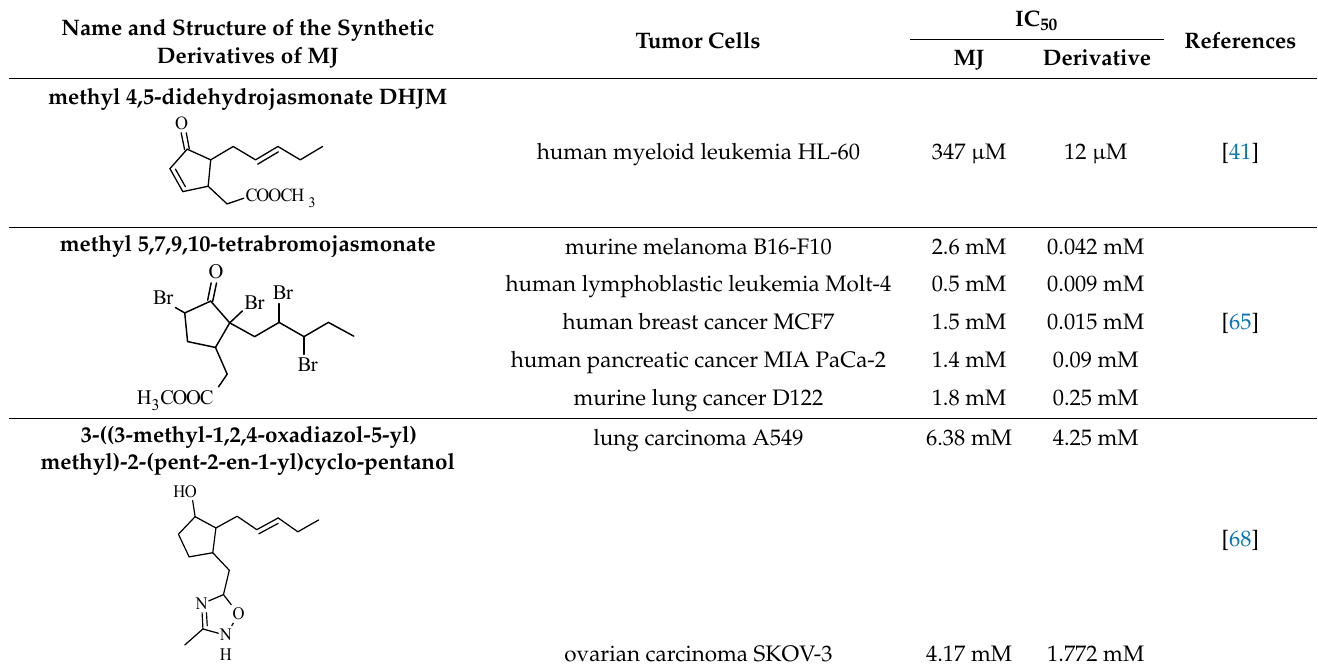
Table 3. Synthetic derivatives of jasmonates with biological properties.